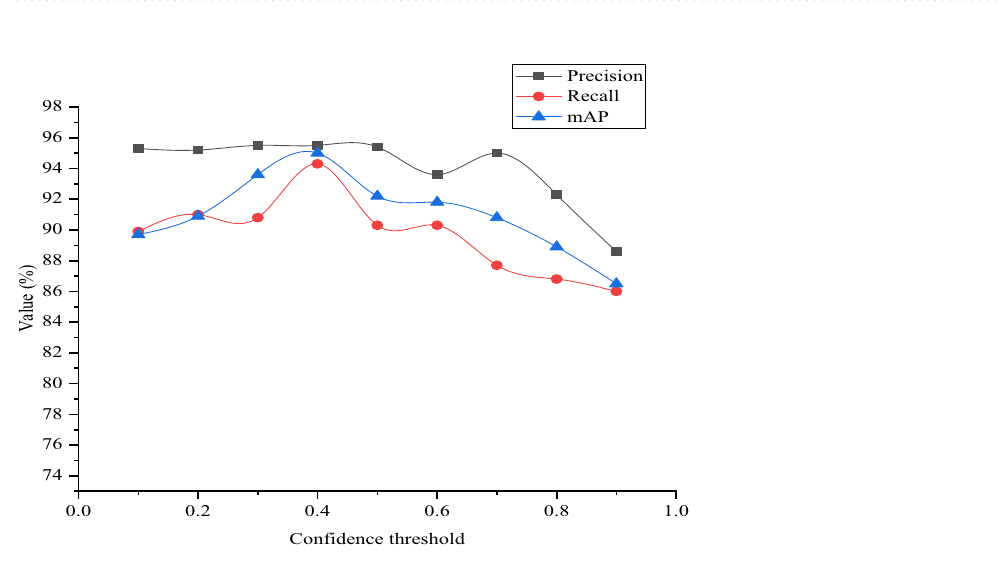
Figure 18. Numerical changes in various parameters under the model.